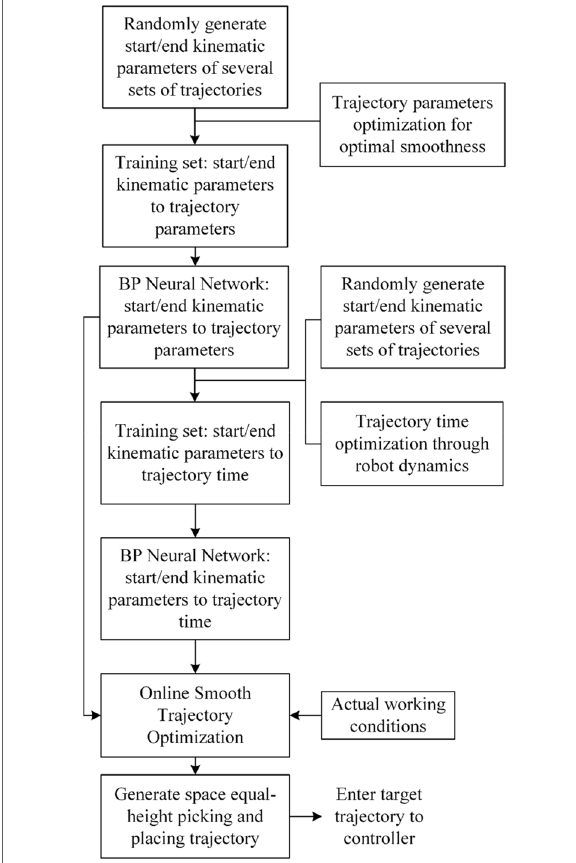
Figure 4 Flow chart of online smooth trajectory